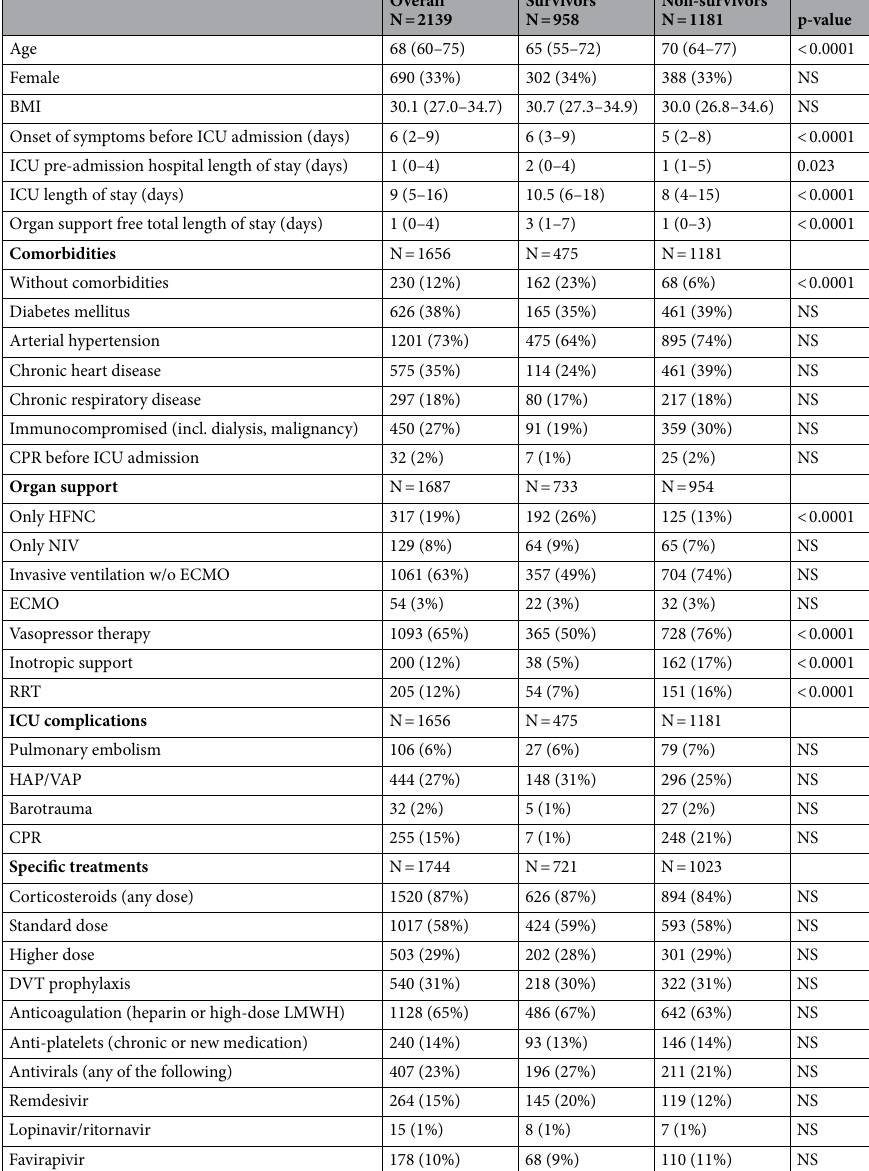
Table 2. Summary of demographics, complications and treatment characteristics. Data are presented as median (25–75th percentile) and absolute number (percentage). For statistical analysis Mann–Whitney U test or Chi square tests were used where appropriate, NS—non-significant. BMI body mass index, CPR cardio-pulmonary resuscitation, DVT deep vein thrombosis, ECMO extracorporeal membrane oxygenation, HAP healthcare-associated pneumonia, HFNC high-flow nasal cannula, ICU intensive care unit, LMWH low molecular weight heparin, NIV non-invasive ventilation, RRT renal replacement therapy, VAP ventilator- associated